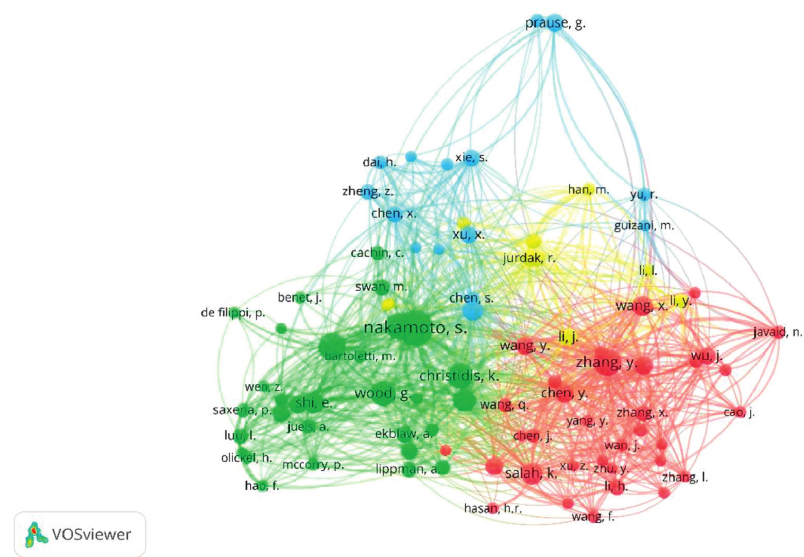
Figure 8: Cocitation authors analysis.